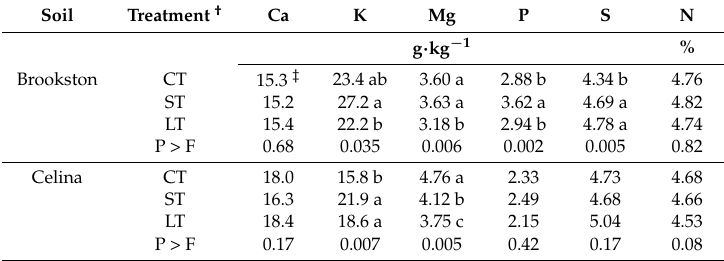
Table 4. Mean concentrations of major plant nutrients (Ca, K, Mg, P, S, and N) in alfalfa shoots grown in a greenhouse at the end of harvest (180 days after planting) in intact cores of two Ohio soils treated with three levels of gypsum. Soil Treatment † Ca K Mg P S N g · kg −